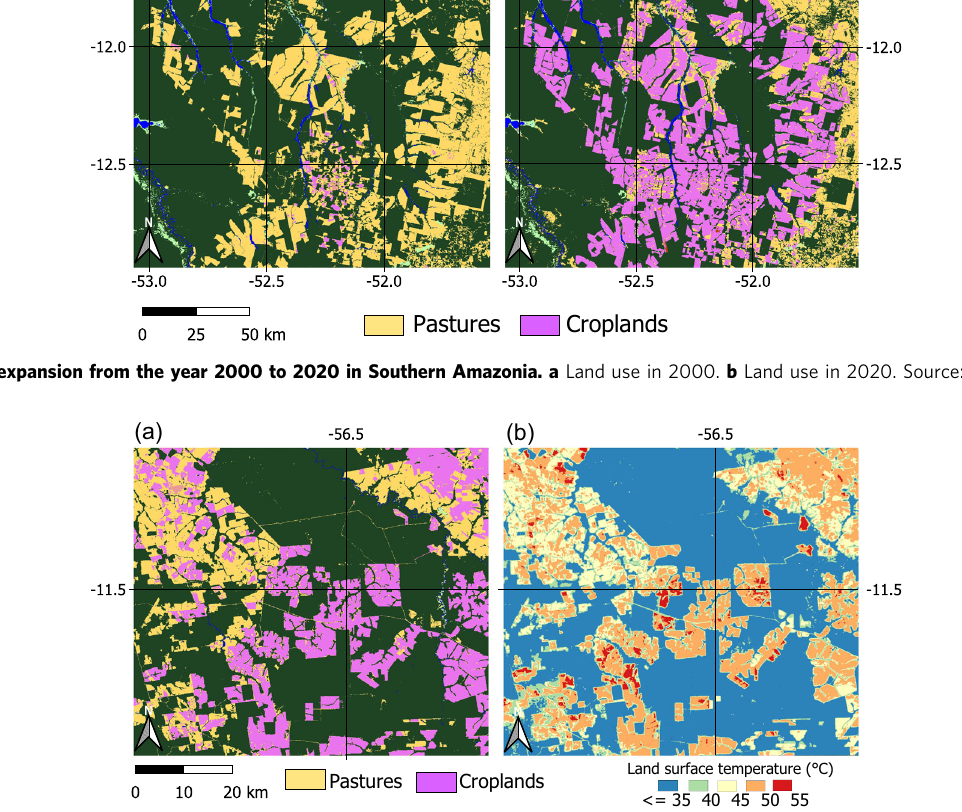
Fig. 2 Land surface temperature over areas with different land use during September 2017. a Land use classi fi cation according to the Mapbiomas project 19 . b Landsat 8 Collection 2 level-2 surface temperature